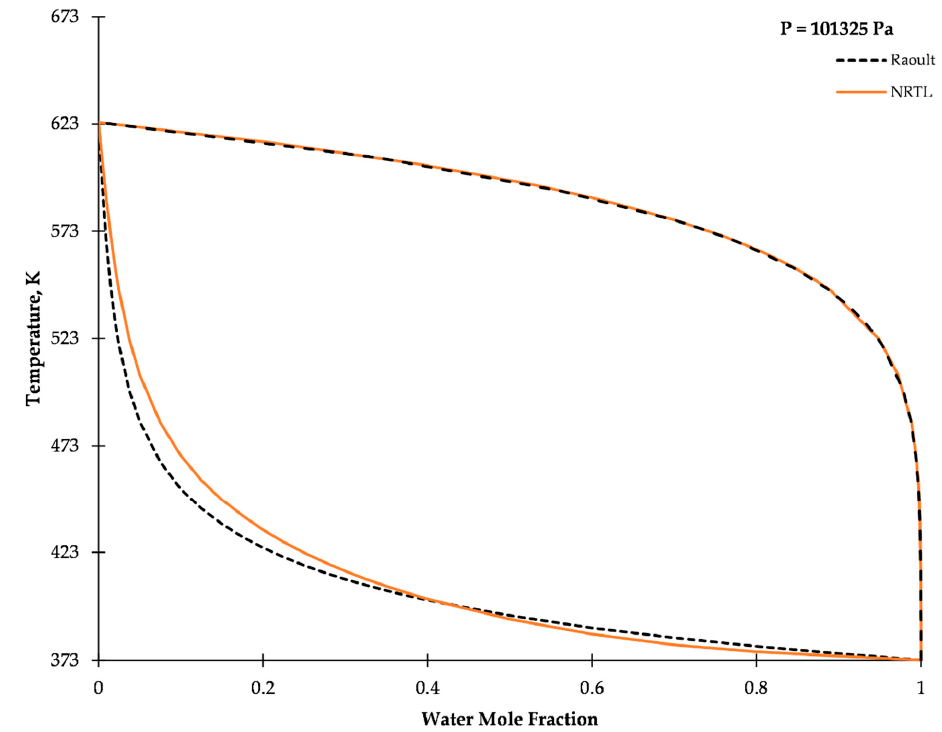
Figure 5. T–xy chart for urea–water system.